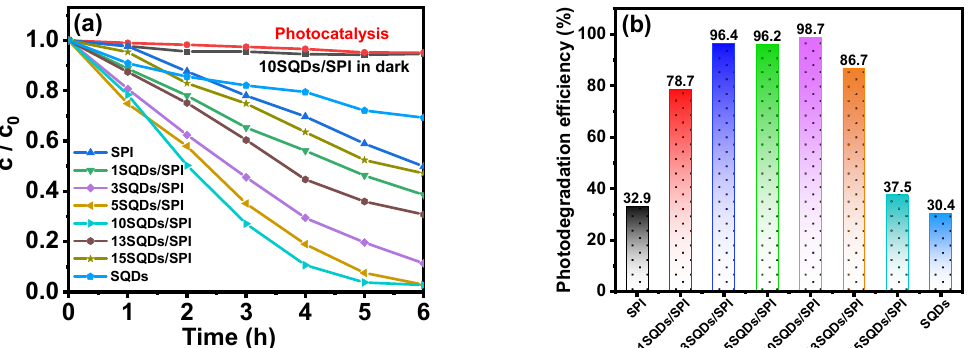
Figure 7. ( a ) Comparison of the photocatalytic degradation of MO over different catalysts under full arc light ( λ > 300 nm). The initial point at t = 0 was used as C 0 . ( b ) Photocatalytic degradation rate of SPI, SQDs and SQDs/SPI composites.